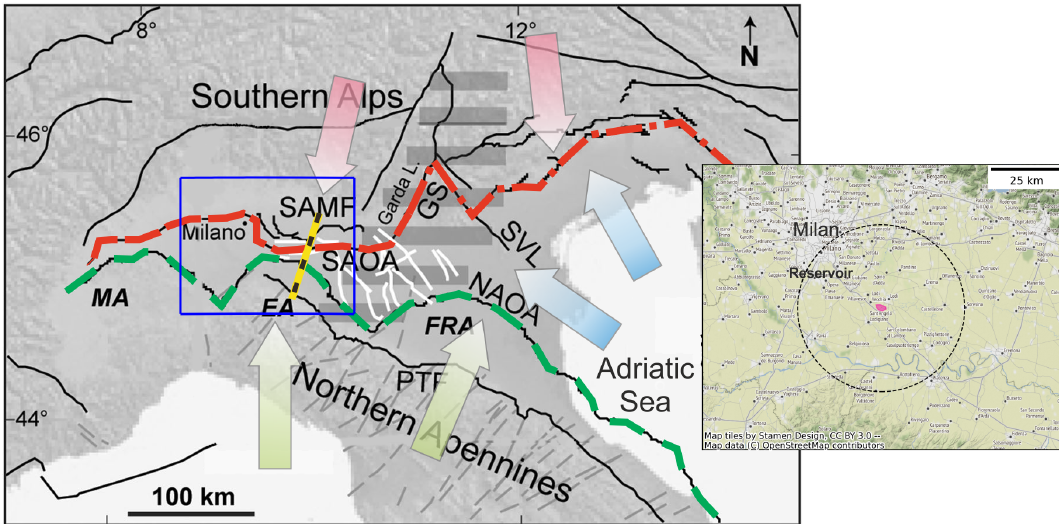
Figure 1. Sketch of northern Italy with the opposite verging mountain systems that surround the Po Plain. Main panel: structural map modified after Vannoli et al. (2015). Black lines: main tectonic elements; white lines: inherited faults; horizontal grey shading: platform of Trento; grey thin traits: seismic profiles. The red and green dashed lines indicate the outermost fronts and arcs of the Southern Alps (SAMF, SAOA) and Northern Apennines (NAOA), respectively; the yellow line is approximately the trace of the profiles shown in Fig. 2. Other acronyms are as follows: SVL: Schio-Vicenza fault; GS: Giudicarie System; MA: Monferrato arc; EA: Emilian Arc; FRA: Ferrarese-Romagnolo arc; PTF: foothills of the Apennines. Coloured arrows show the approximate direction of convergence linked respectively to the Eurasia (red), Africa (green), and Adria plates (blue). In the inset, a blow-up of the study area, with the location of the Cornegliano Laudense USG (pink area), and a 30km distance frame (OD domain, black dashed circle) (© OpenStreetMap contributors, 2021. Distributed under the Open Data Commons Open Database License (ODbL)